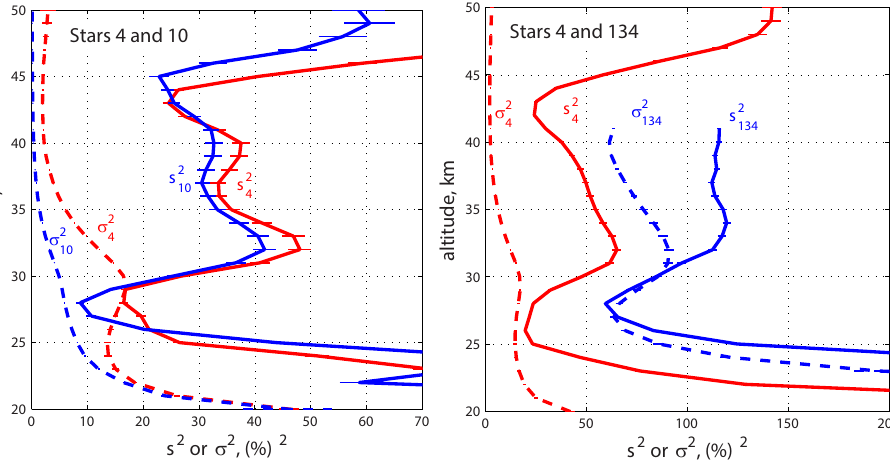
Figure 3. Sample variances s 2 March 2008; (right) for stars 4 and